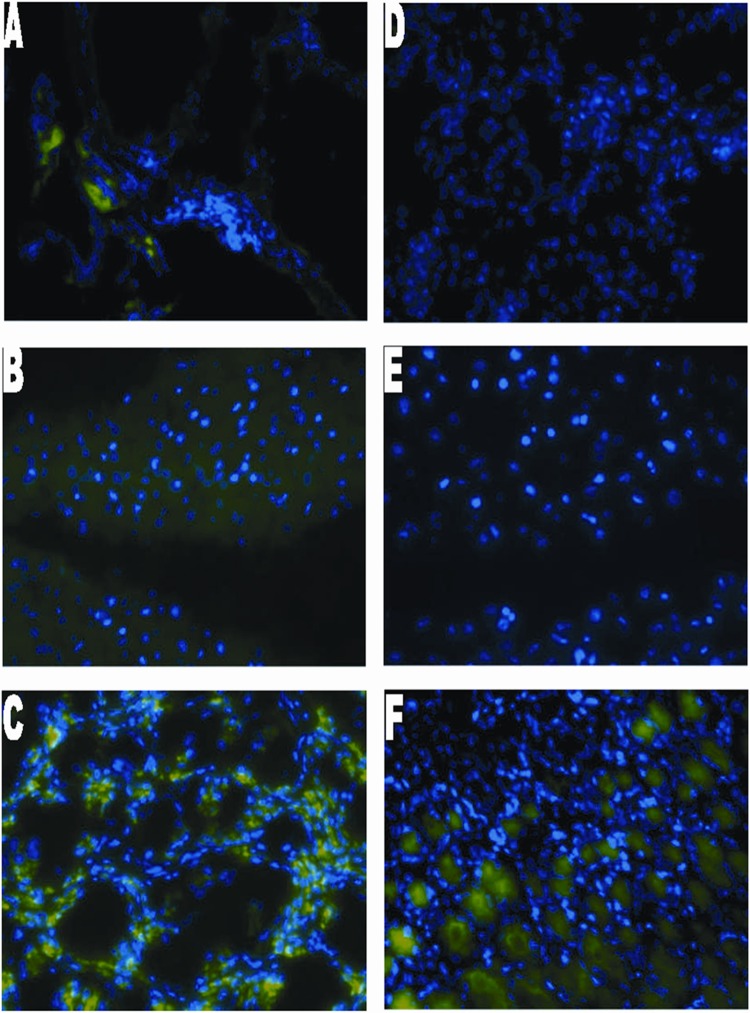
Immunofluorescence staining of rat tissue with MUC5AC.Panel A to F show immunofluorescence staining for metastatic lung, metastatic liver, metastatic stomach, non-metastatic lung, non-metastatic liver and non-metastatic stomach, respectively for representative cases. Positive MUC5AC cytoplasmic staining was detected in all metastatic samples with the Alexa Fluor 488 secondary antibody, conjugated to a green fluorophore. Metastasis negative liver and lung show the absence of MUC5AC staining. However, metastasis negative stomach stains positive for MUC5AC as gastric mucin M1 antigen is found in mucus cells of gastric epithelium.